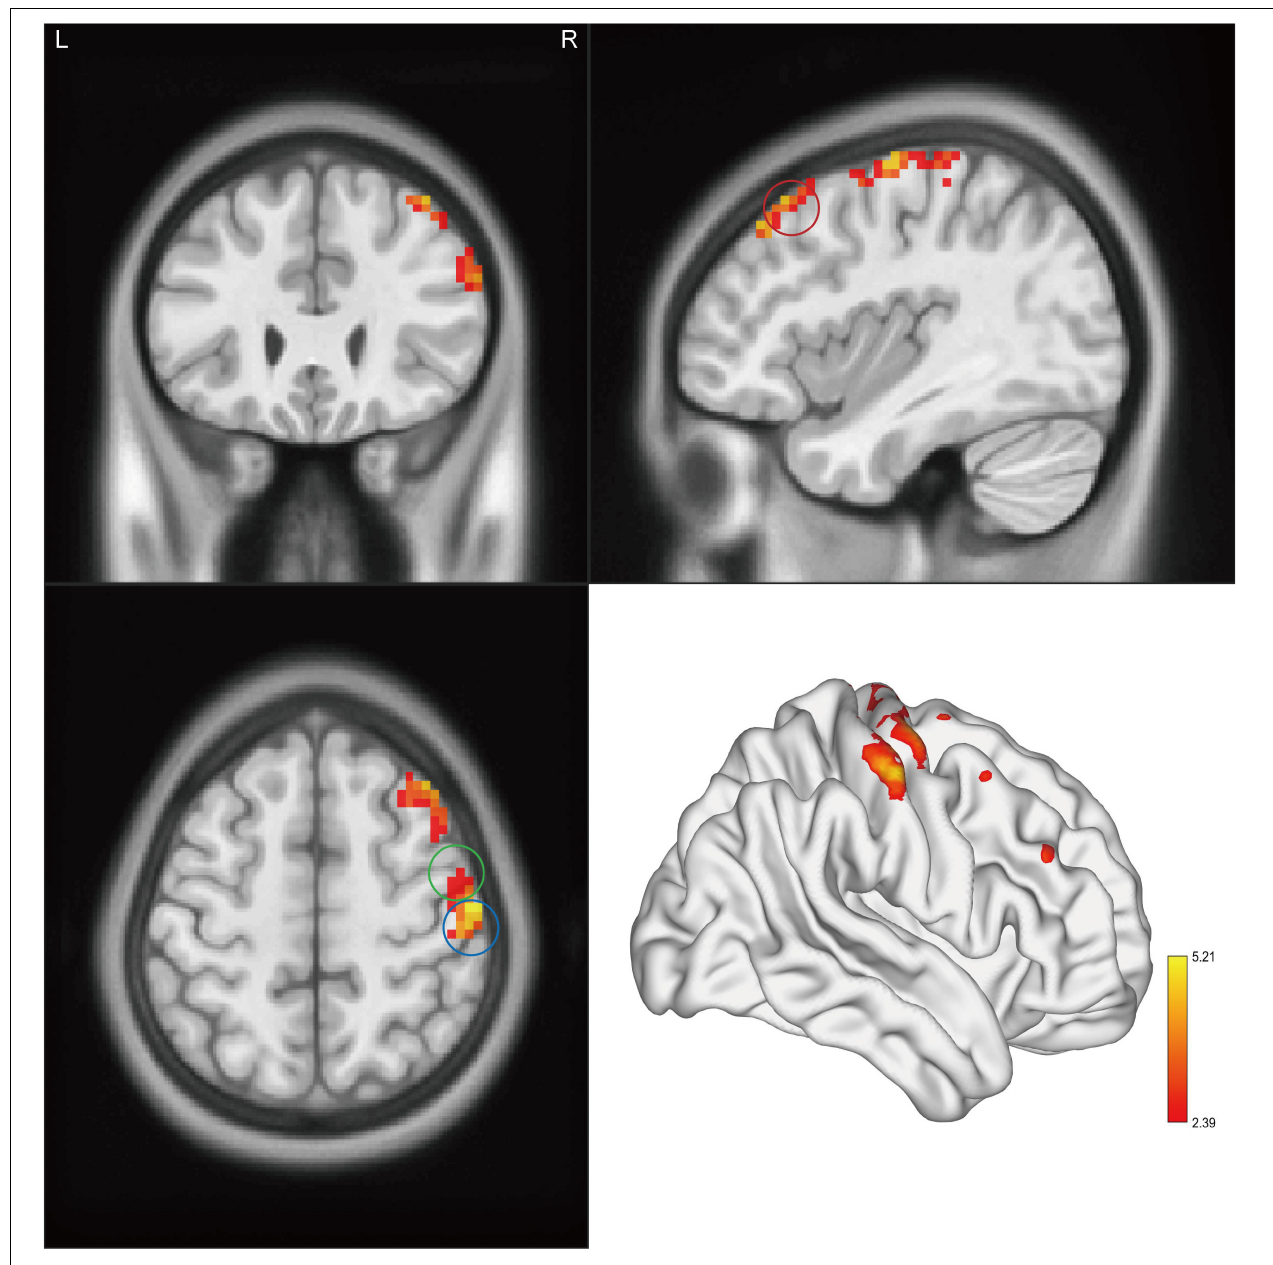
FIGURE 3 | Clusters showed a significant difference in ReHo between CAI patients and HCs. The color bar indicated the t -value from two-sample t -test. The circles indicated the corresponding brain regions. The green circle: the right precentral gyrus; the blue circle: the right postcentral gyrus; and the red circle: the right middle frontal